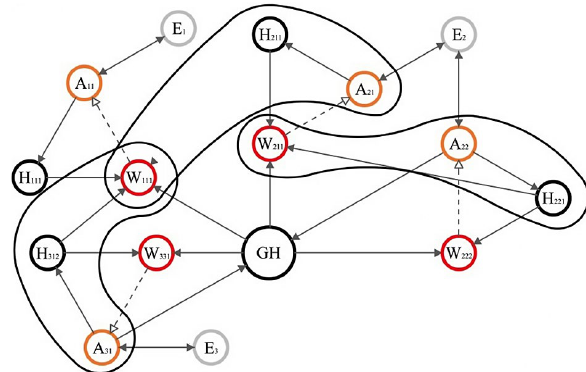
Figure 8. Peer-induced